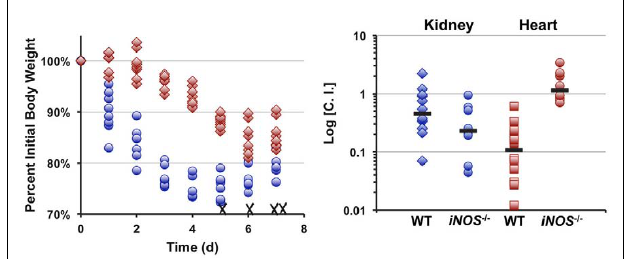
FIGURE 4 | Lqo is required for full S. aureus virulence in a murine sepsis model, particularly in establishing myocarditis. Left: Eight 4-to 6-week female C57BL/6 mice (two independent experiments each with four mice per group) were inoculated i.v. with 5 × 10 6 cfu of S. aureus strain Newman (blue circles) or isogenic Δ lqo (red diamonds).Weight loss was monitored following inoculation and presented as percent initial body weight. Once mice lose ≥ 30% of their original body weight, they are sacrificed as per IACUC protocol.WT infected mice exhibited significantly greater weight loss ( p < 0.01, using longitudinal linear regression to model weight loss over time, SAS ® , Cary, NC, USA) and four (50%) were sacrificed (indicated with X). Right: Competitive indices (C.I.) were established by infecting mice i.v. with 1 × 10 7 cfu of a 1:1 mixture ofWT: Δ lqo S. aureus strain Newman. Organs were harvested 5days post-inoculation and mutant:WT C.I. ratios were calculated as outlined in experimental procedures. In parallel, isogenic iNOS − / − mice unable to produce inflammatory NO · were also infected in a similar manner.